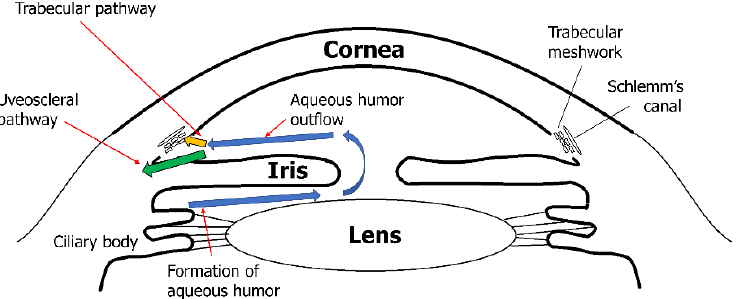
Figure 3. Aqueous humor production and outflow in the eye. Aqueous humor (AH) is produced in the ciliary body. After AH enters the posterior chamber of the eye, it flows through the pupil and enters the anterior chamber of the eye (blue arrows). About 60 to 80% of AH outflows to the trabecular pathway (yellow arrow) and others pass through the uveoscleral pathway (green arrow). Increased matrix metalloproteinase (MMP) activity in the trabecular meshwork elevates AH outflow, which in turn reduces intraocular pressure (IOP). However, decreased MMP activity in the trabec-